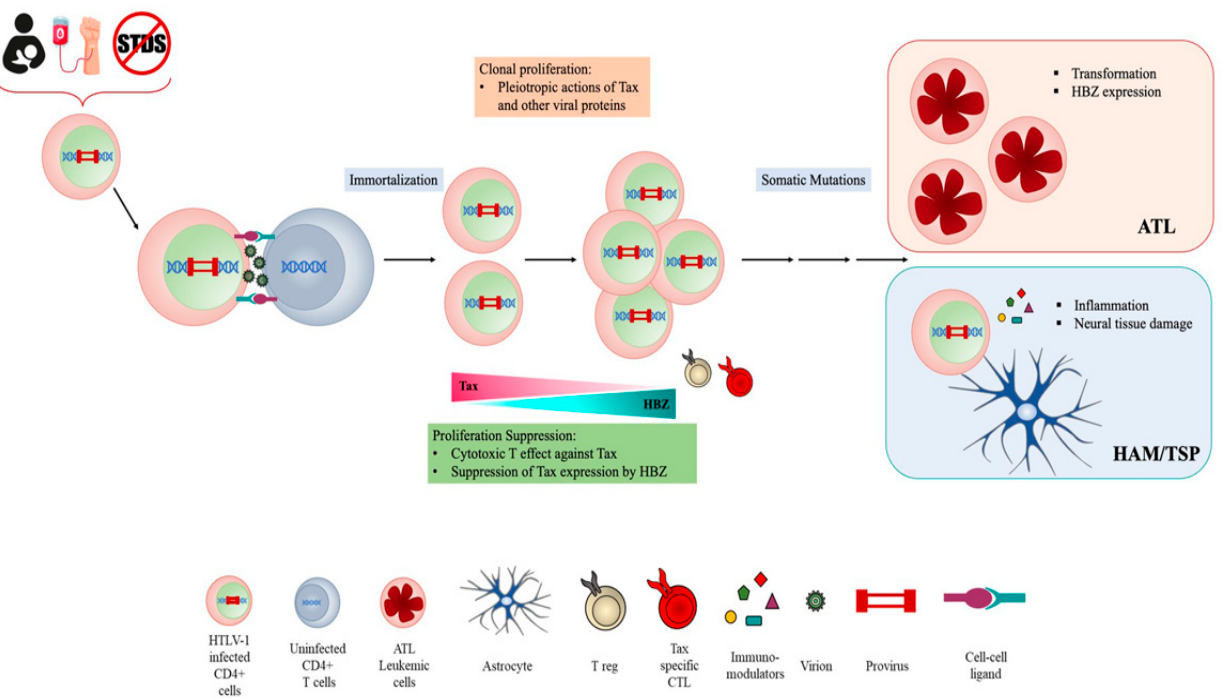
Figure 1. HTLV cell infection and transmission.